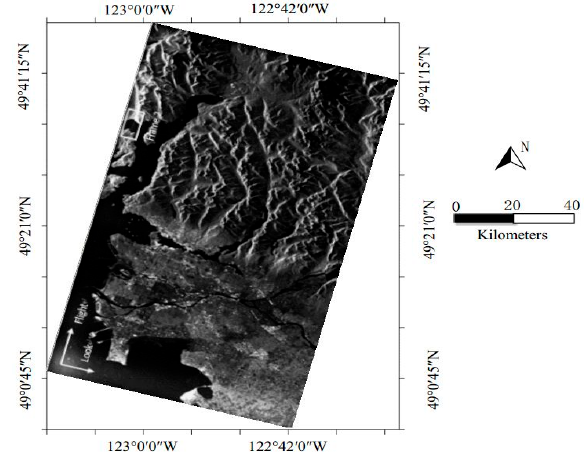
Figure 10. RADARSAT-1 (RADARSAT is a Canadian remote sensing Earth observation satellite program overseen by the Canadian Space Agency) SAR image of Vancouver collected on 16 June 2002, at 02:24 UTC.